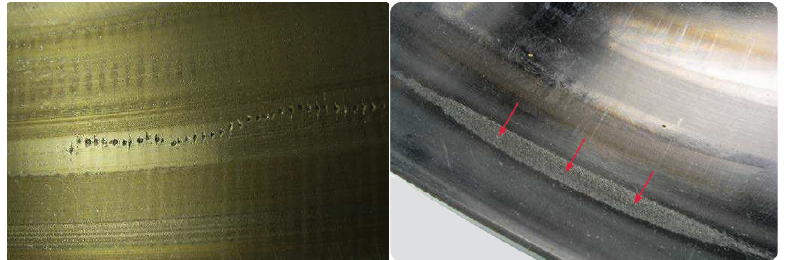
Figure 6. Electrical erosion failures. Excessive current ( left ) and current leakage ( right ) [27]. Courtesy of